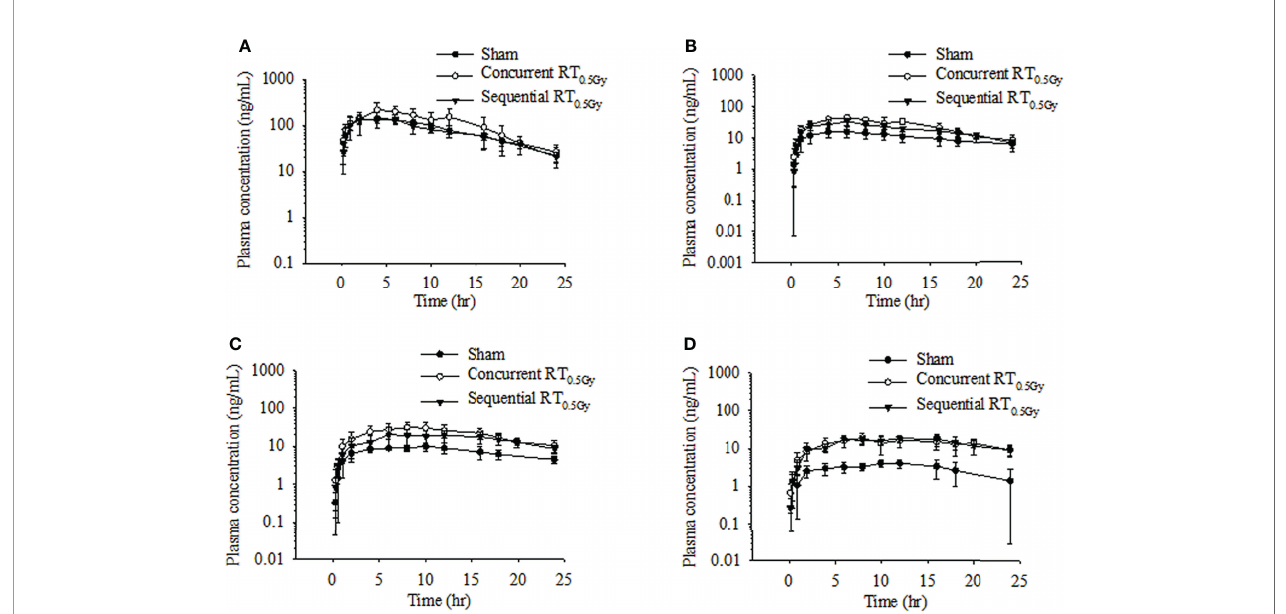
FIGURE 2 | Time – concentration curve of tamoxifen (A) , 4-hydroxytamoxifen (B) , N-desmethyltamoxifen (C) , and endoxifen (D) in rat plasma after oral administration at the dose of RT 0Gy or RT 0.5 Gy . ( ● ) Sham group: tamoxifen administration (10 mg/kg, p.o.) plus RT 0Gy ; ( ○ ) Concurrent RT 0.5Gy group: tamoxifen administration (10 mg/kg, p.o.) plus RT 0.5Gy ; ( ▼ ) Sequential RT 0.5Gy group: tamoxifen administration (10 mg/kg, p.o.) plus RT 0.5Gy . Data are expressed as the mean ± standard deviation ( n = 6 per group).